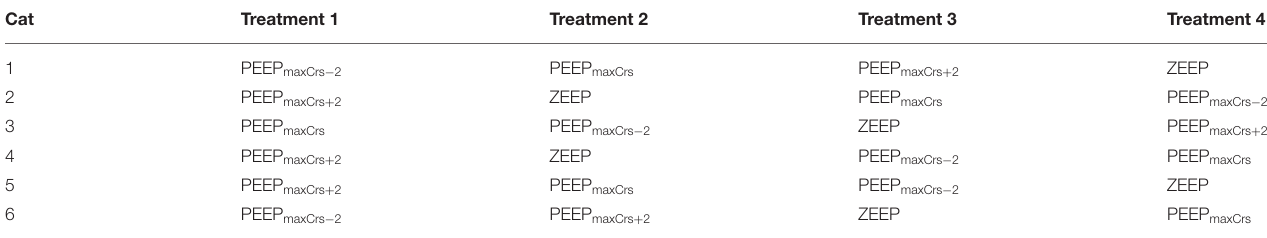
TABLE 1 | Order of end-expiratory treatments in the six cats of this study. Cat Treatment 1 Treatment 2 Treatment